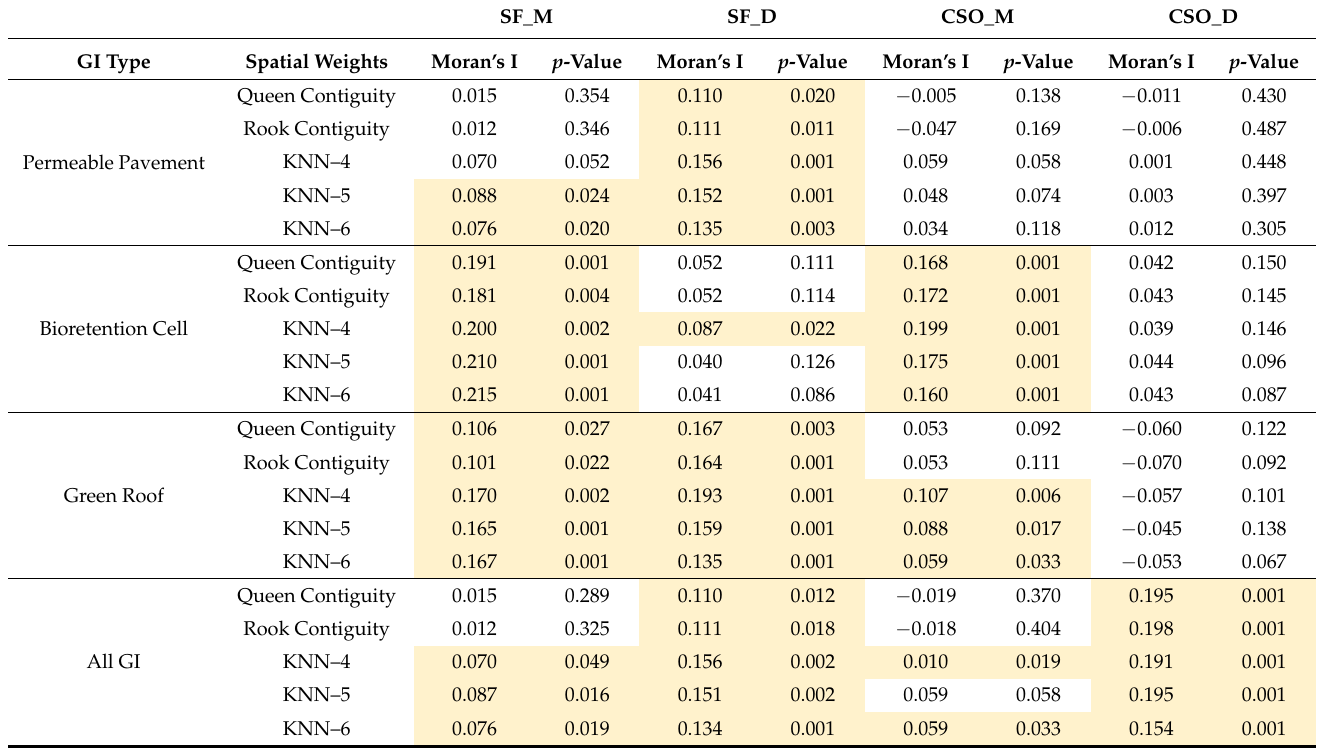
Table 3. Moran’s I and statistic for spatial autocorrelation in GI impact on resilience. The positive and significant spatial autocorrelation are highlighted in